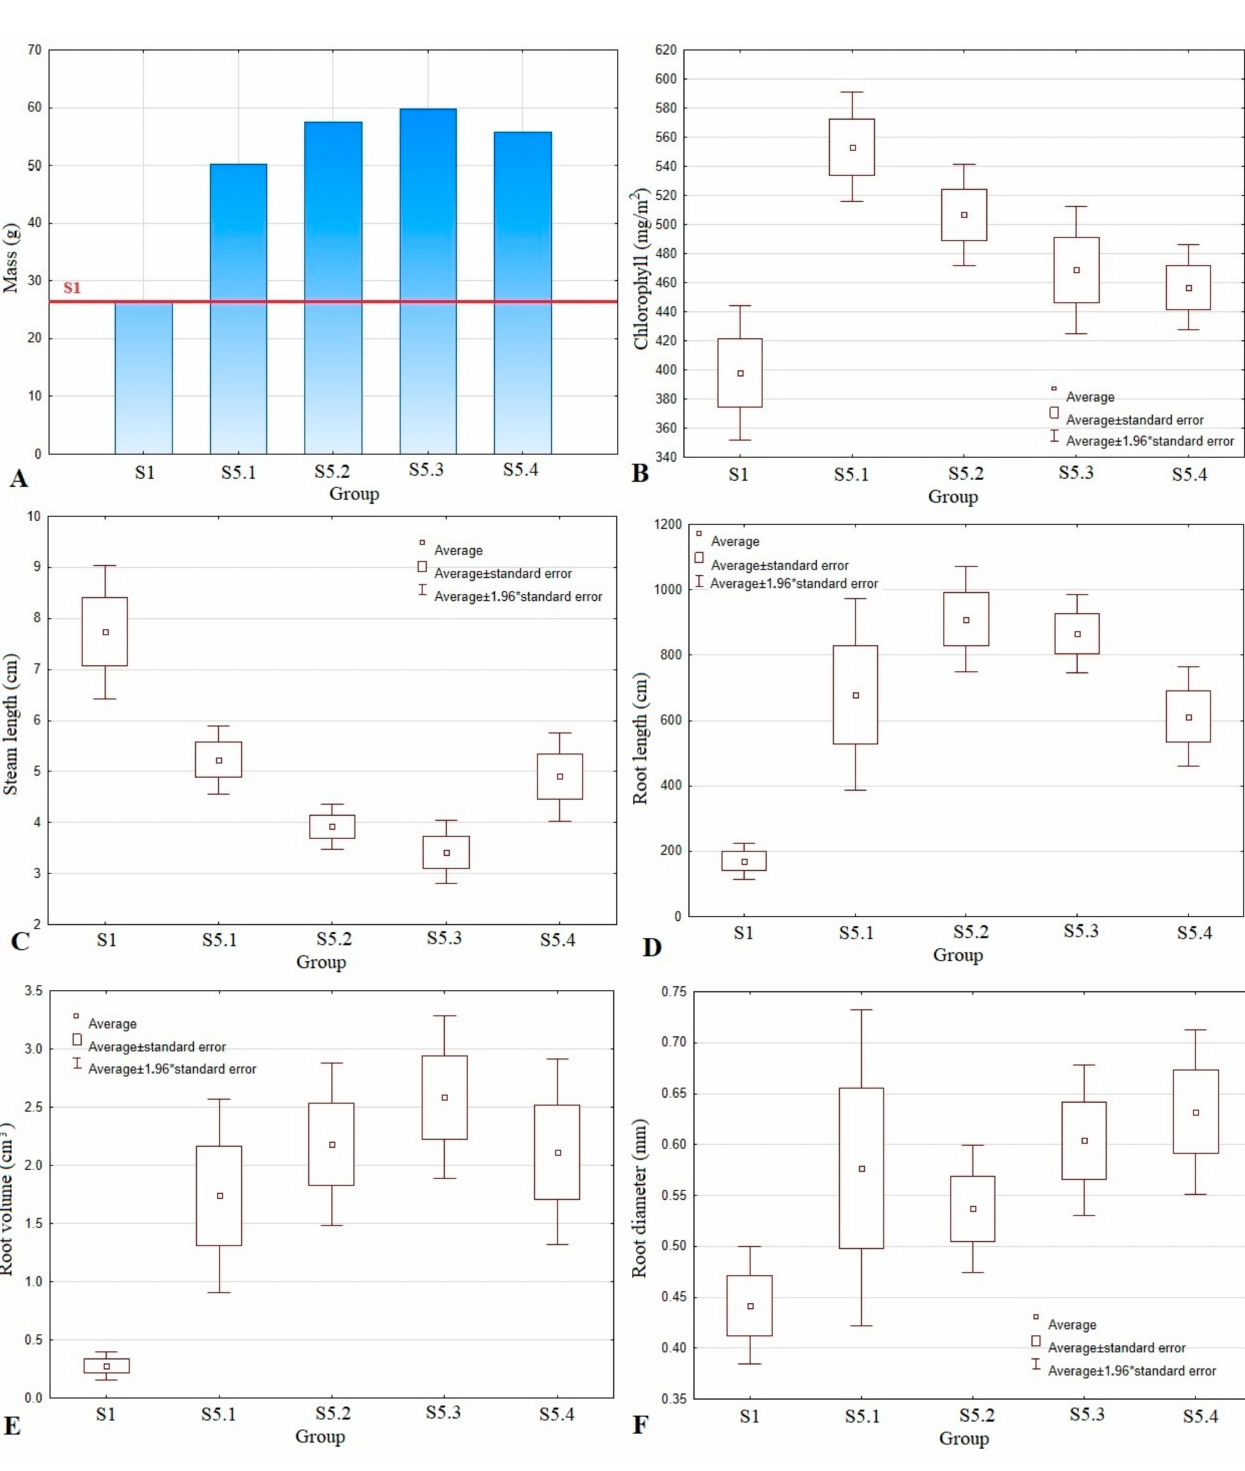
Figure 5. Cucumber sprout growth parameters: fresh mass ( A ), chlorophyll content ( B ), steam length ( C ), root length ( D ), root volume ( E ), and root diameter ( F ) (S1—Uncoated seeds, S5.1—Seed coating containing a solution of 2% alginate with amino acids (37.6 mL/100 g), micronutrients (37.5 mL/100 g), and NPK, S5.2—Seed coating containing a solution of 2% alginate with amino acids (75.1 mL/100 g), micronutrients (75.1 mL/100 g), and NPK, S5.3—Seed coating containing a solution of 2% alginate with amino acids (112 mL/100 g), micronutrients (112 mL/100 g), and NPK, S5.4—Seed coating containing a solution of 2% alginate with amino acids (150 mL/100 g), micronutrients (150 mL/100 g), and